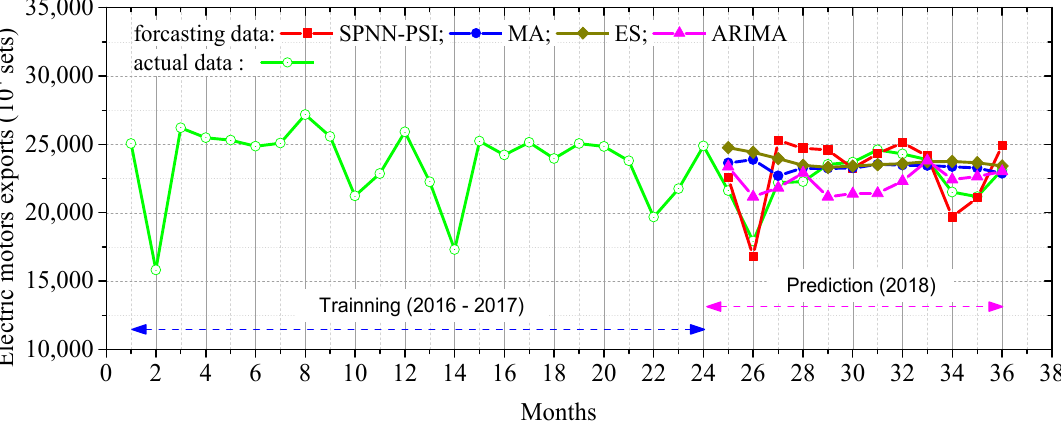
Figure 4. Time series pattern and prediction on the electric motors exports (EME) dataset.